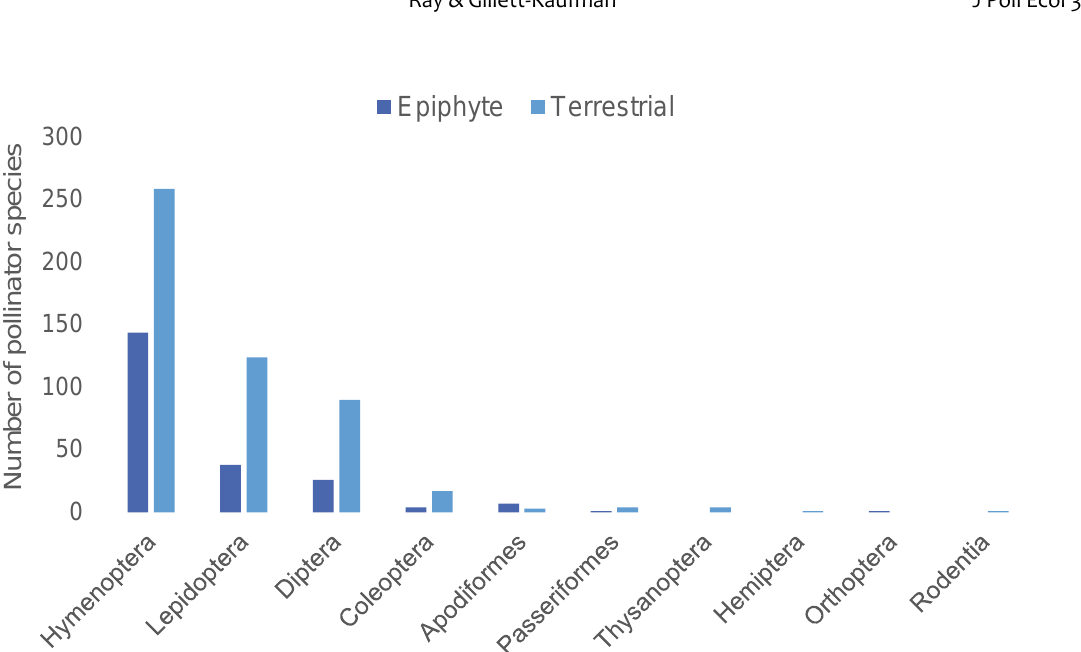
Figure 1. The total number of pollinator species of each order. For example, there were 144 species of Hymenoptera pollinating epiphytic orchids, and 259 species of Hymenoptera pollinating terrestrial orchids. A full list of the numbers for each order can be found in Table